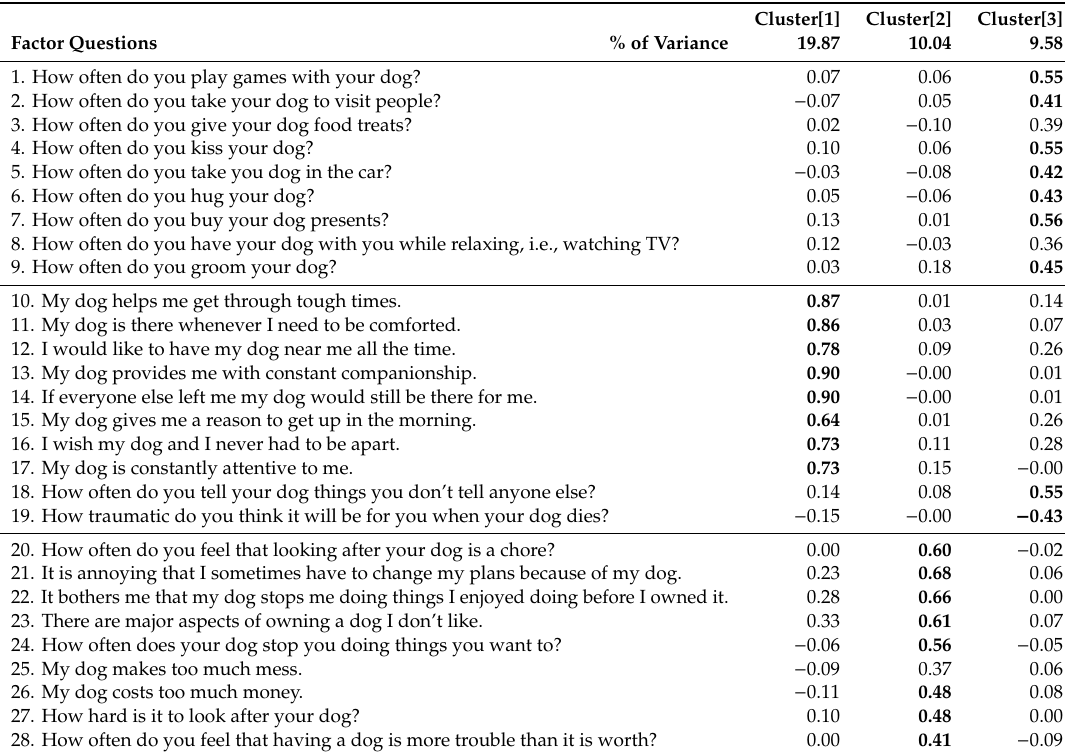
Table 2. The results of the principal component analysis (PCA) of the Dutch translation of the MDORS questionnaire (N = 501). The analysis was performed according to the three factors originally found by Dwyer et al. [14], which resulted in the production of three score clusters. Component scores above 0.4 or below − 0.4 are marked in bold